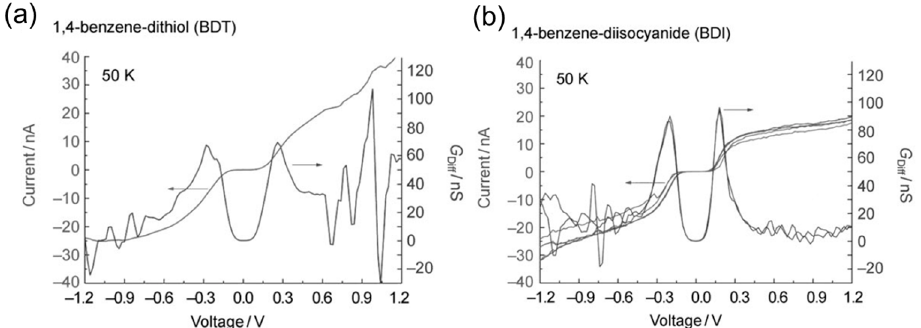
Figure 9. The I – V curves and corresponding transmission curves of ( a ) 1,4-benzene–dithiol, and ( b ) 1,4-benzene–diisocyanide single-molecule junctions. Reproduced with permission from [51] copyright ChemPhysChem Publishing Group 20011.